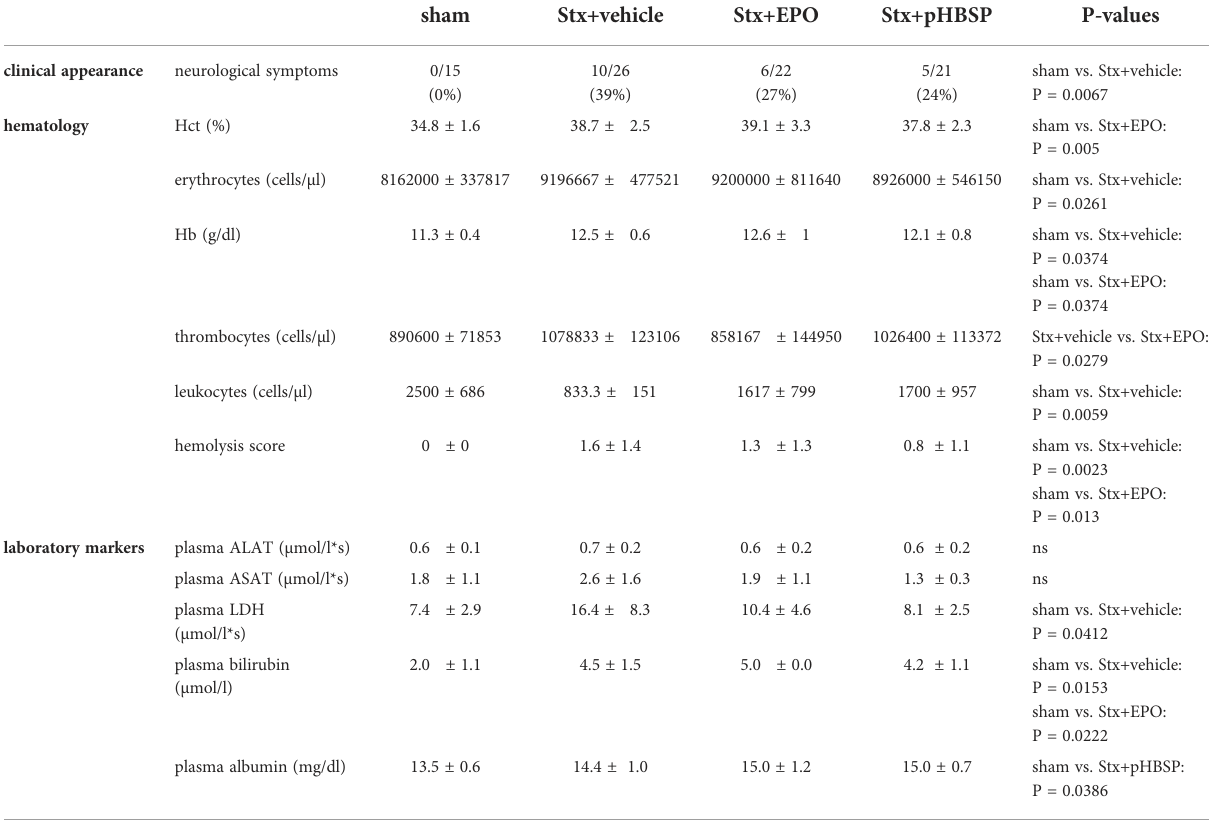
TABLE 3 Hematological and laboratory parameters of mice with HUS and effects of EPO and pHBSP